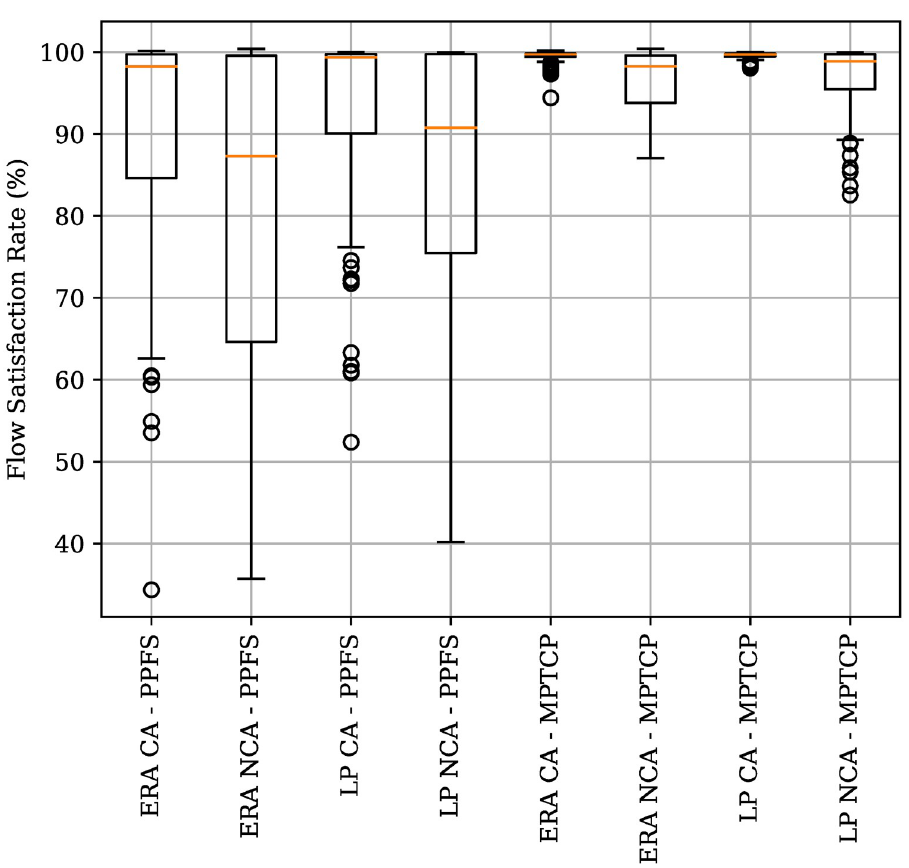
Fig 11. Boxplot showing the distribution of the flow’s satisfaction rate for various multipath routing techniques. MPTCP: MultiPath TCP, PPFS: Per-Packet Flow Split [26], ERA: Evolutionary Routing Algorithm, LP: